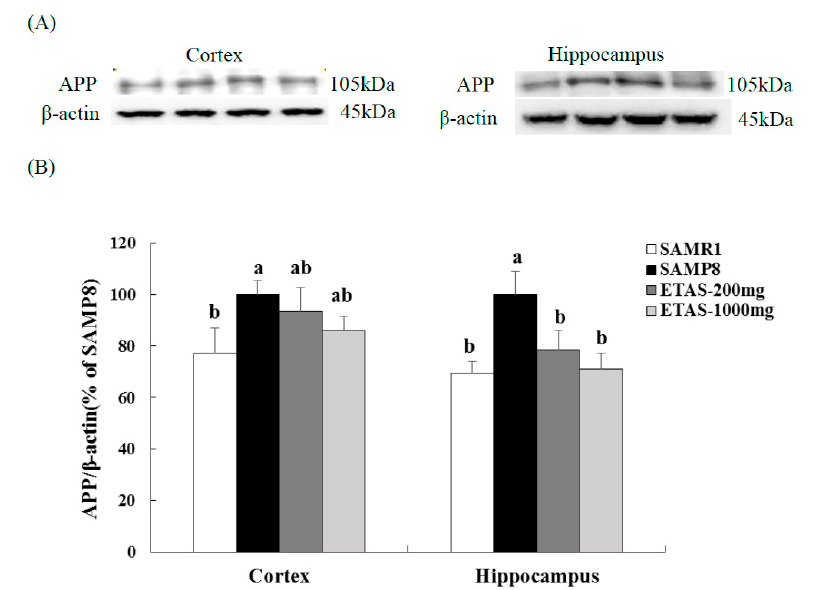
the 1000 mg/kg BW ETAS ® group (Figure 4). These results indicated that ETAS ® decreased A β accumulation by downregulating the APP and BACE-1 expressions.